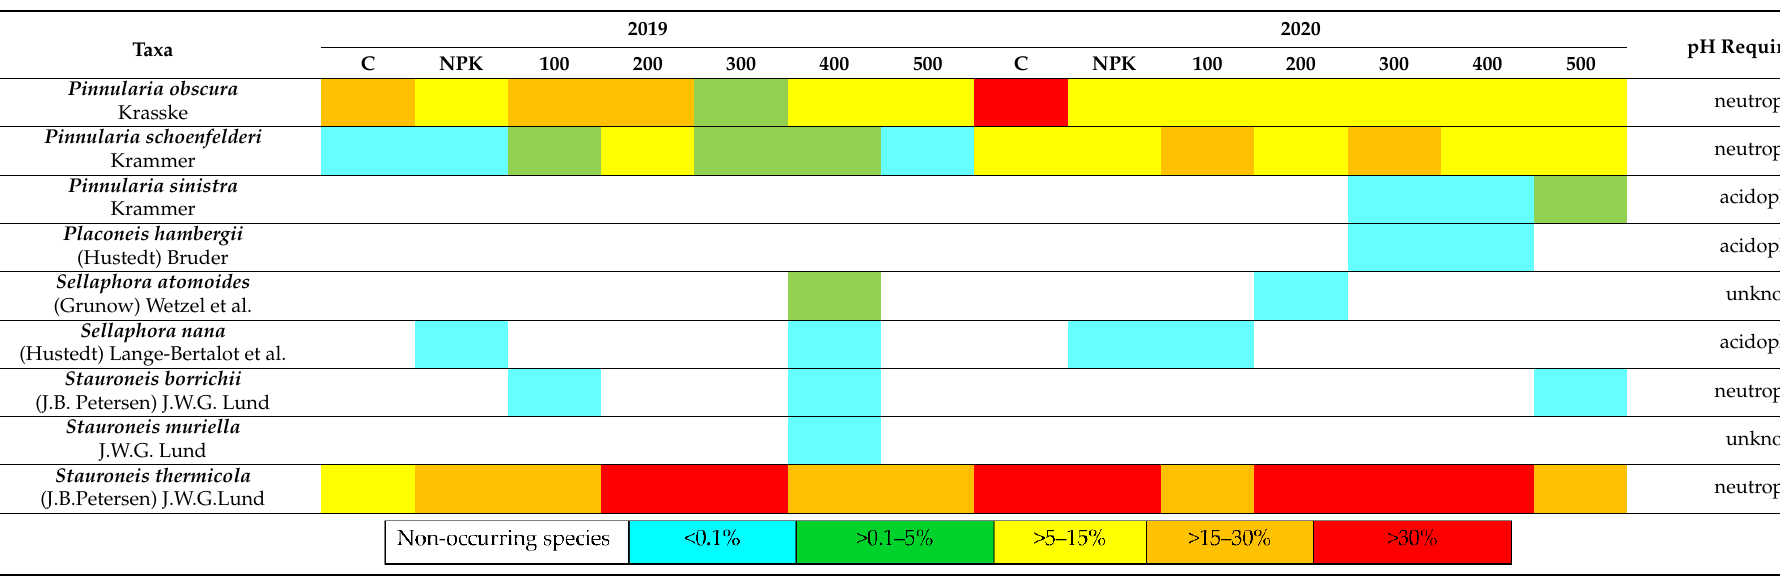
Figure 4. Dominant and some selected diatom taxa observed during the study: ( A , B ) Hantzschia amphioxys (Ehrenberg) Grunow; ( C – E ) Nitzschia pusilla Grunow; ( F – H ) Stauroneis thermicola (J.B. Petersen) J.W.G. Lund; ( I , J ) Pinnularia obscura Krasske; ( K,L ) Pinnularia schoenfelderi Krammer; ( M – Q ) Mayamaea atomus (Kützing) Lange-Bertalot; ( R – T ) Mayamaea per- mitis (Hustedt) K. Bruder and Medlin; ( U ) resting form of unidentified Mayamaea sp. ; ( V , W ) Sellaphora nana (Hustedt) Lange-Bertalot, Cavacini, Tagliaventi and Alfinito; X- Microcostatus aerophilus Stanek-Tarkowska, Noga, C.E. Wetzel and Ector. Currently, approximately 250 diatom taxa are considered as species with an ability to grow in terrestrial habitats. However, most studies of terrestrial diatoms are focused on areas of Europe and polar regions [23]. Therefore, it can be expected that the real num- ber of terrestrial species is substantially higher, which seems to have been confirmed re- cently by taxonomic investigations covering both Europe [28–31] and tropical zones [32–